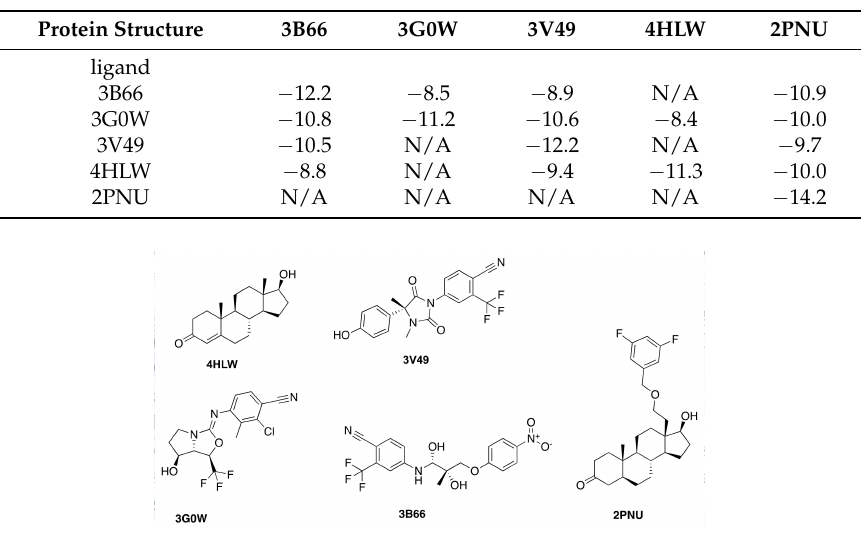
Table 1. Results from the cross-docking experiment. Listed are the PDB IDs of the ligands and corresponding protein structures together with their Glide-Scores.